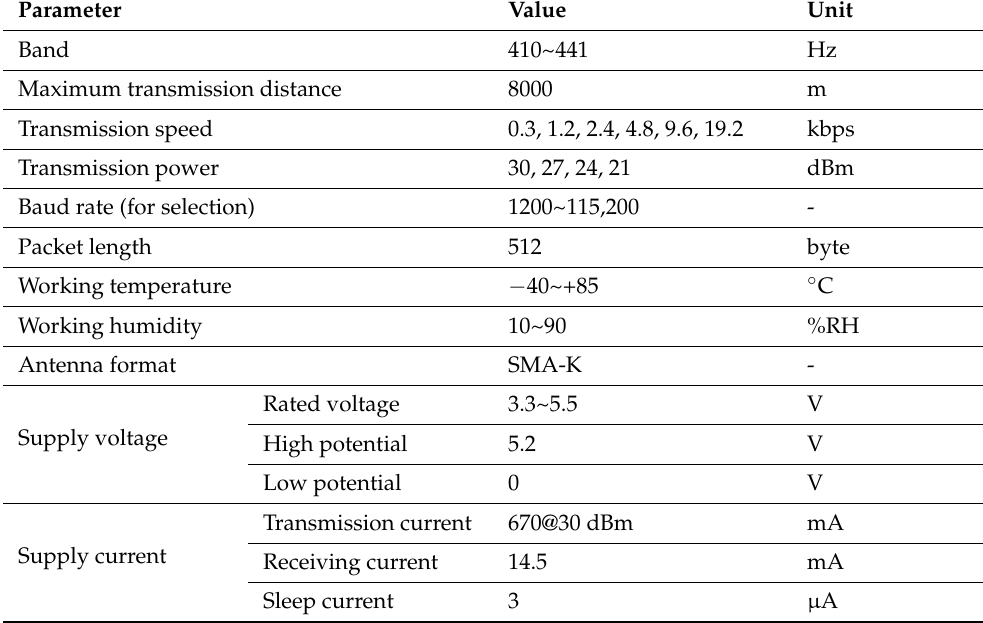
Table 3. Module specification